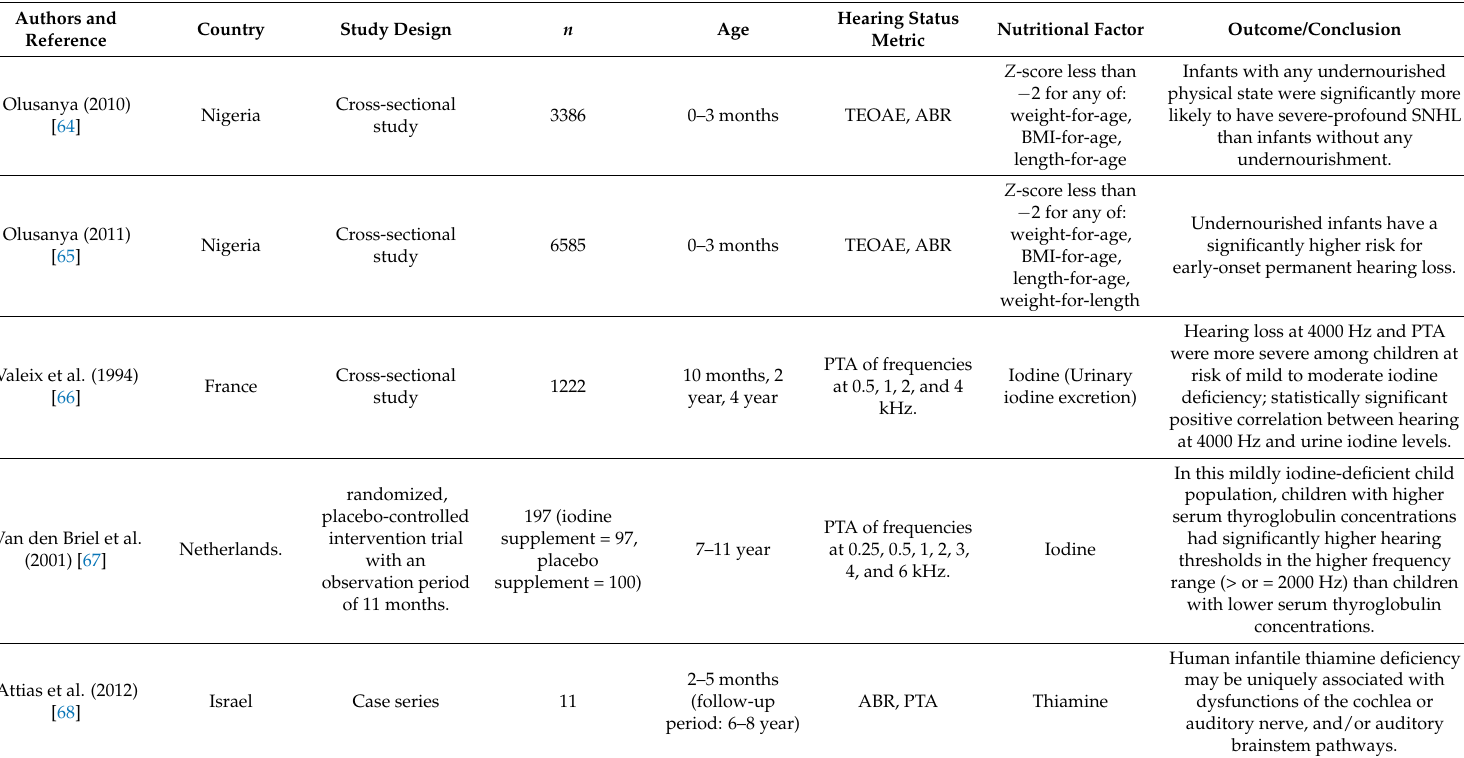
Table 3. Studies assessing the association between pediatric hearing status and